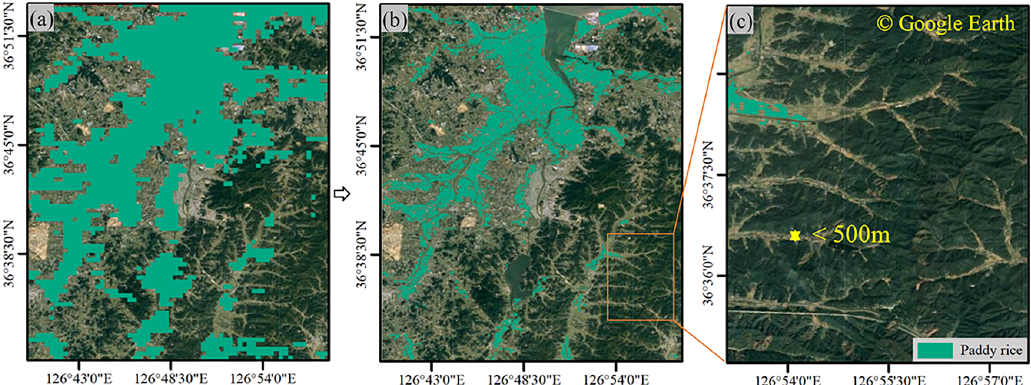
Figure 10. Estimated distribution of paddy rice in 2017 in mountainous regions in South Korea: (a) flooding signal based on MODIS indices, a (b) paddy rice map generated by our method, and (c) mountainous landscapes acquired from © Google Earth.. The example data for b can be found at the following link: https://doi.org/10.17632/cnc3tkbwcm.1 (Han et al., 2021b; see example 04).